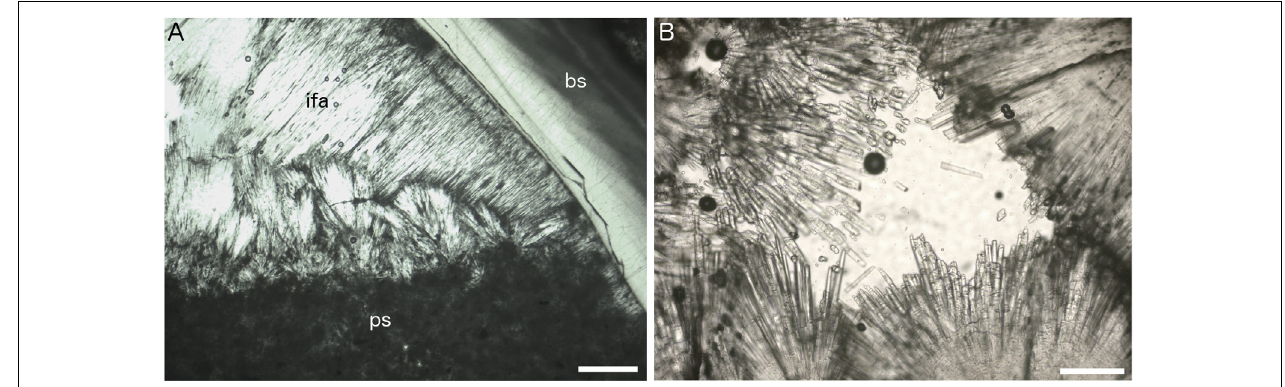
FIGURE 5 | Petrographic thin section images of Fossil Hill seep carbonates. (A) Isopachous fibrous aragonite cement (ifa) and peloidal micritic sediment (ps) forming geopetal fill within shelter cavity formed by articulated vesicomyid bivalve shell (bs), plain polarized light, sample DR630 R-3, and scale bar is 200 µ m. (B) Detail of isopachous fibrous aragonite crystals, plain polarized light, sample DR629 R-5, and scale bar is 80 µ